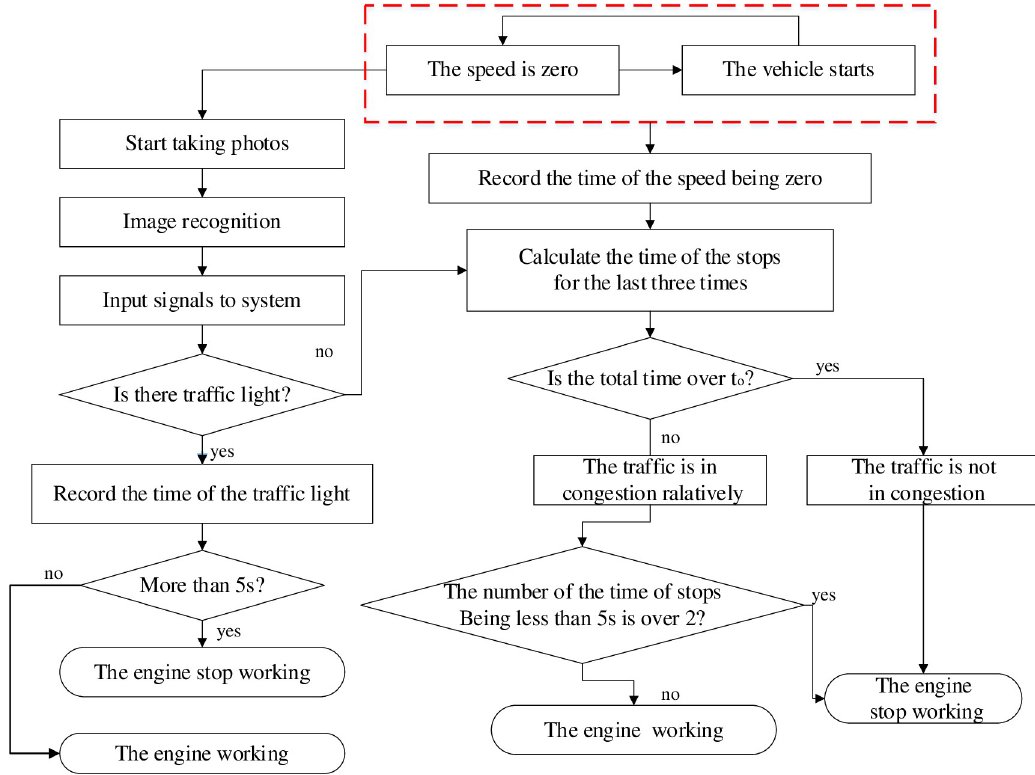
Fig 1. The flow chart of IEST working